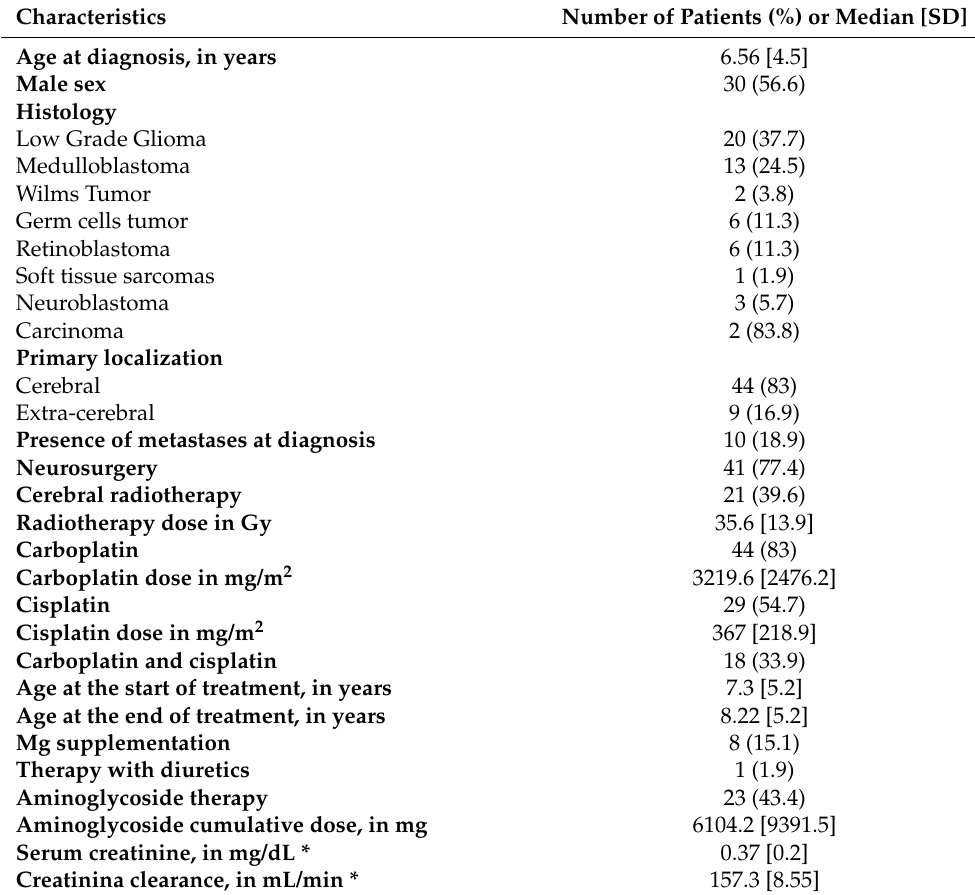
Table 1. Demographic and clinical characteristics of the patients enrolled ( n =